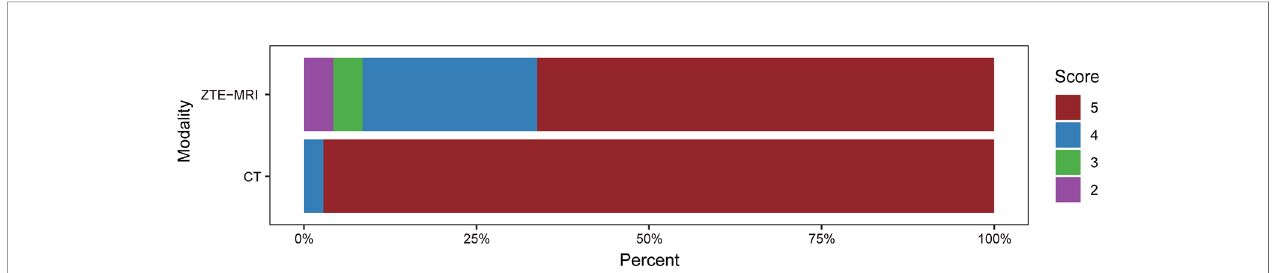
FIGURE 1 | Histogram of the subjective image quality scores for lung ZTE-MRI and